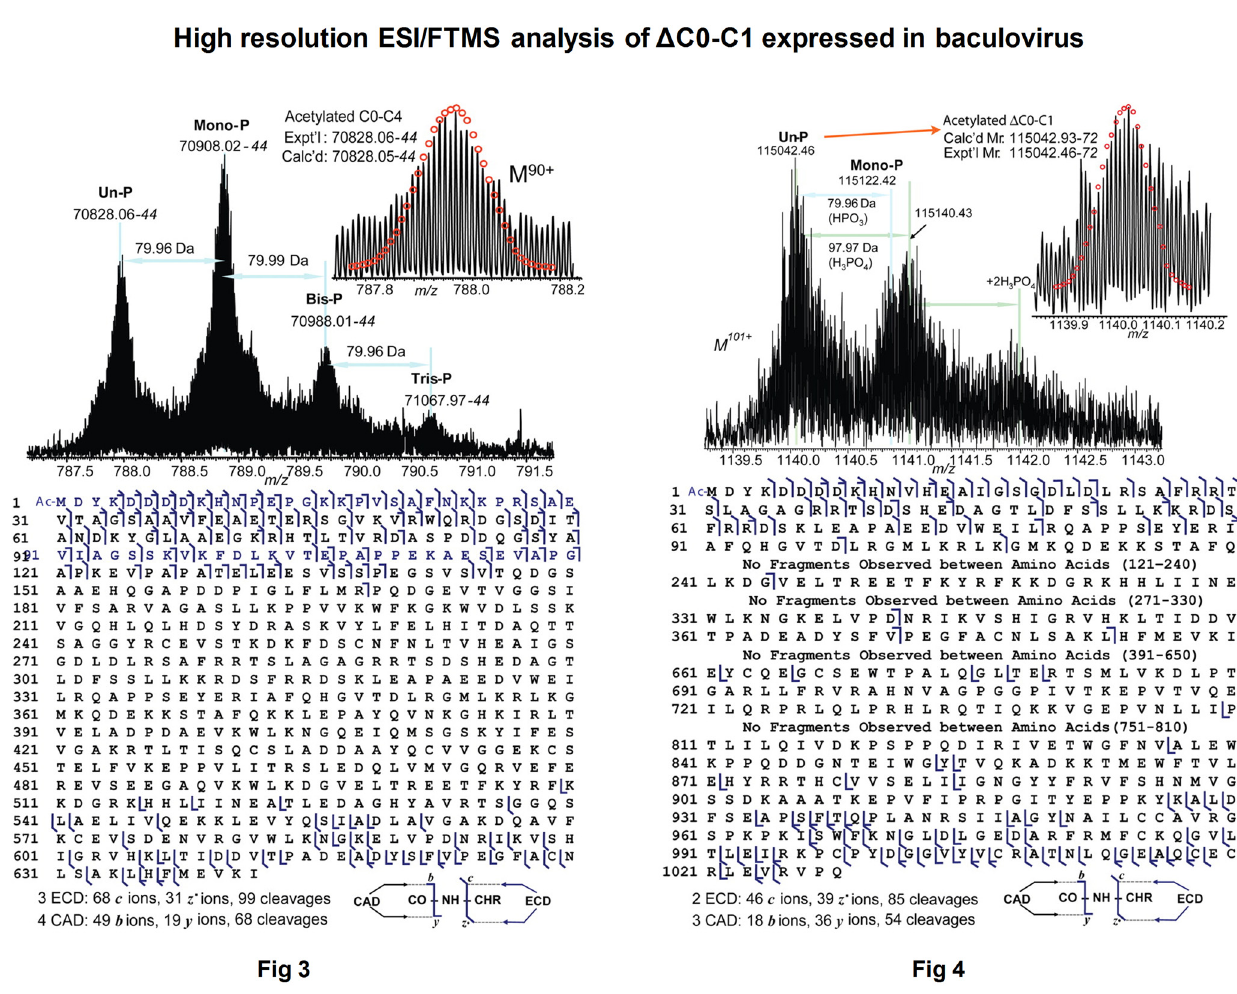
Figure 6. Two complimentary experiments in separate figures. ‘‘Fig. 3’’ and ‘‘Fig. 4’’ appearing in the article [25].